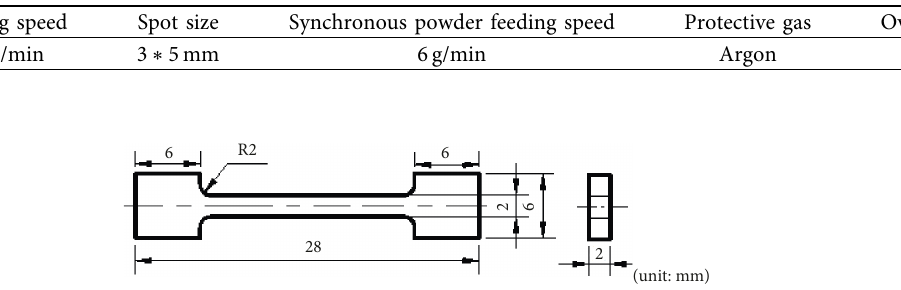
Table 3: Laser process parameters.